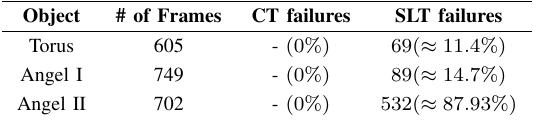
TABLE III N UMBER OF F